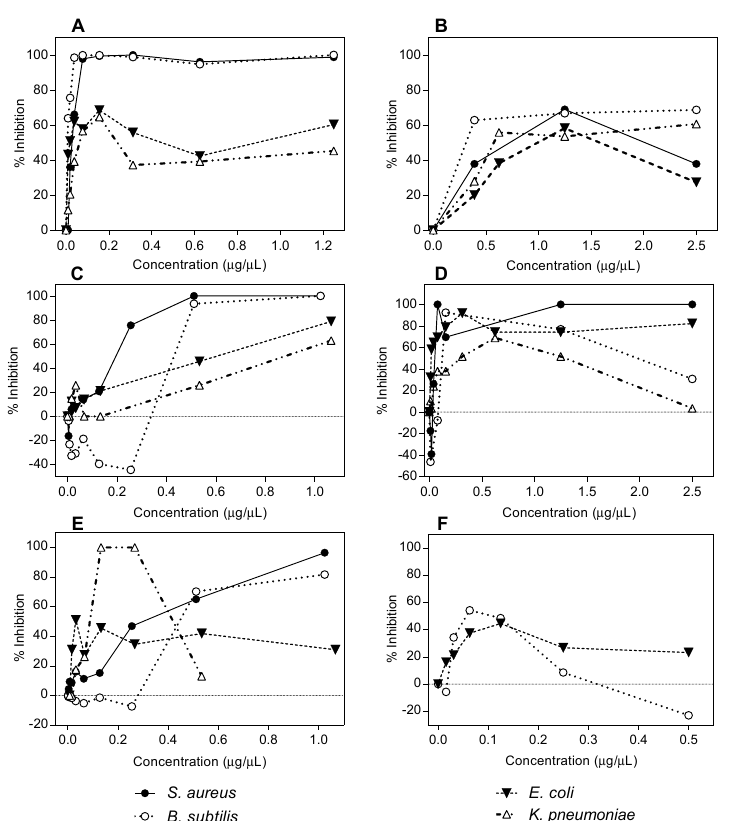
Figure 2. Effect of flavonoids on the stationary phase bacterial growth. Bacteria (2 × 10 8 ufc/mL, 10 μ L in a final volume of 150 μ L) were incubated stationary at 37 °C for 18 h in the presence of different concentrations of flavonoids in lysogeny broth (LB) in 96-well micro dilution plates. The final optical density (O.D.) in each well was measured in an Enzyme-Linked ImmunoSorbent Assay (ELISA) detector at 540 nm. ( A ) pinocembrin; ( B ) 7- O -methyleriodictyol; ( C ) galangin; ( D ) quercetin; ( E ) 3- O -methylgalangin; and( F ) 3,7- O -dimethylgalangin. The graphs are representative of the results of three replicates.